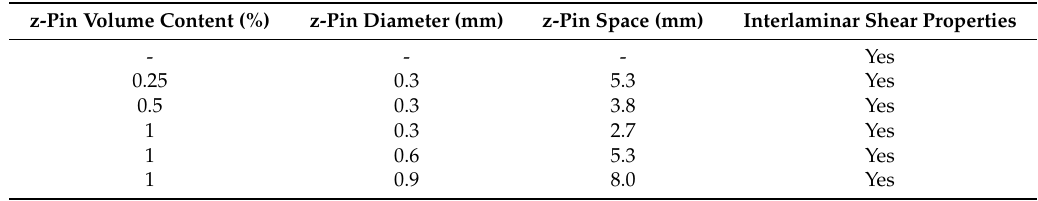
Table 2. Short-beam shear interlaminar test matrix of laminate